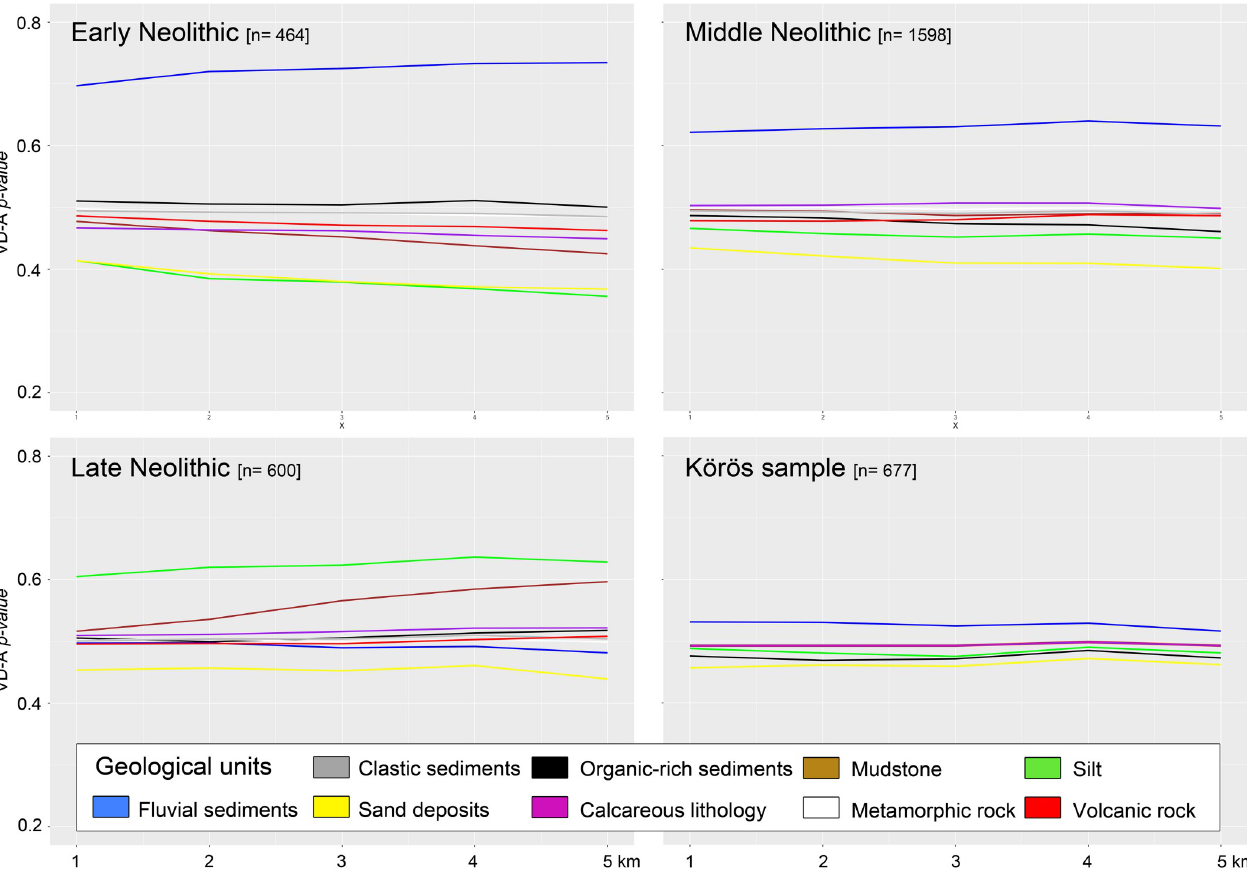
Fig 9. VD-A statistics of the geological units and the EN, MN, LN, and the Ko¨ro¨s sample. There is a significant preference for alluvial sediments throughout the EN and the MN. The LN sites show different signals with a clear preference of silt deposits (loess). Soil that developed over sand deposits were avoided by all ‘cultural groups’ during the Neolithic